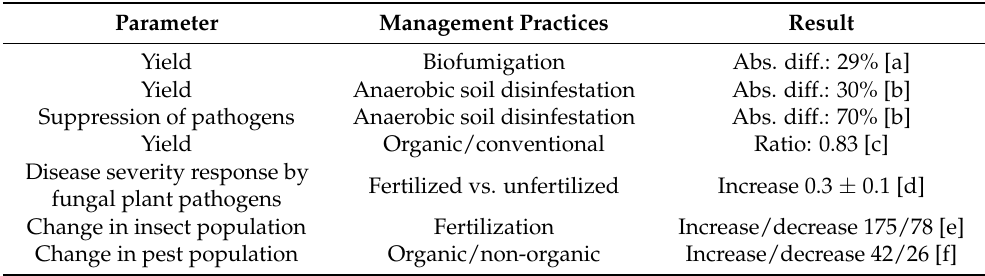
Table 3. Pest management: main effects as reported in meta-analysis studies. See also Table S6. Parameter